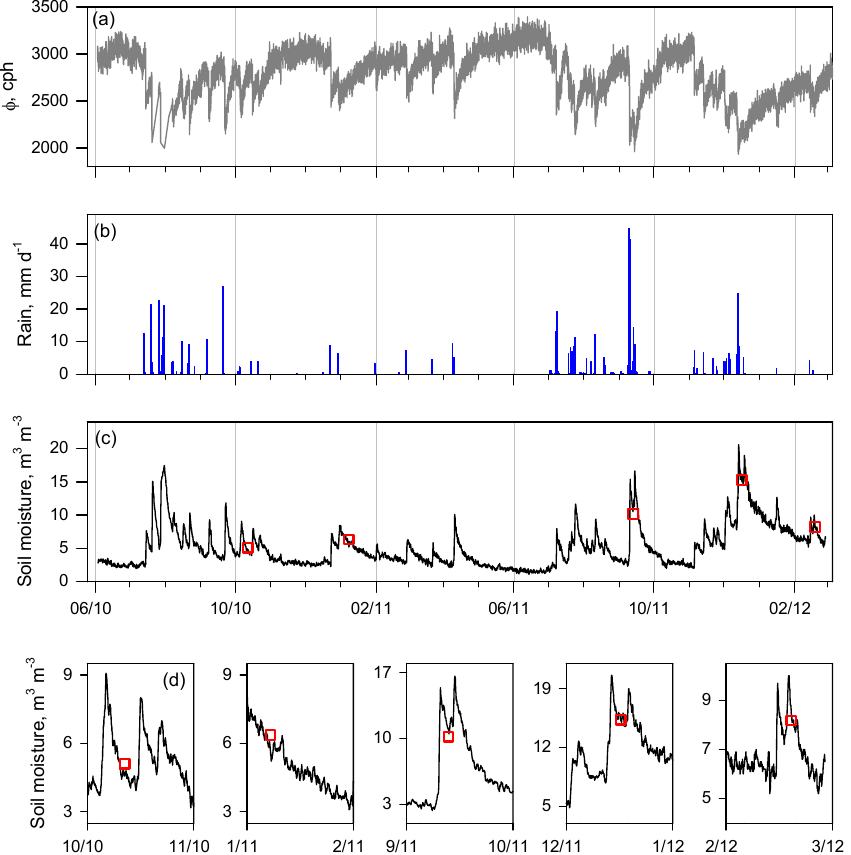
Fig. 12. COSMOS data from the Santa Rita site, near Tucson, Arizona, USA. Fast neutron intensity (a) was corrected for temporal changes in the incoming neutron intensity, atmospheric pressure and atmospheric water vapor. The rainfall intensity (b) is the average of 12 rain gauges distributed within 200 m of the COSMOS probe. Neutron-derived soil moisture (c, d) are computed using Eq. (4) with neutron intensity normalized using Eq. (A1), and is smoothed using a 12-h running average filter. Five separate soil moisture data sets (red squares), each based on multiple soil samples collected within the COSMOS footprint and measured gravimetrically following oven drying, are shown for comparison with the neutron-derived data.